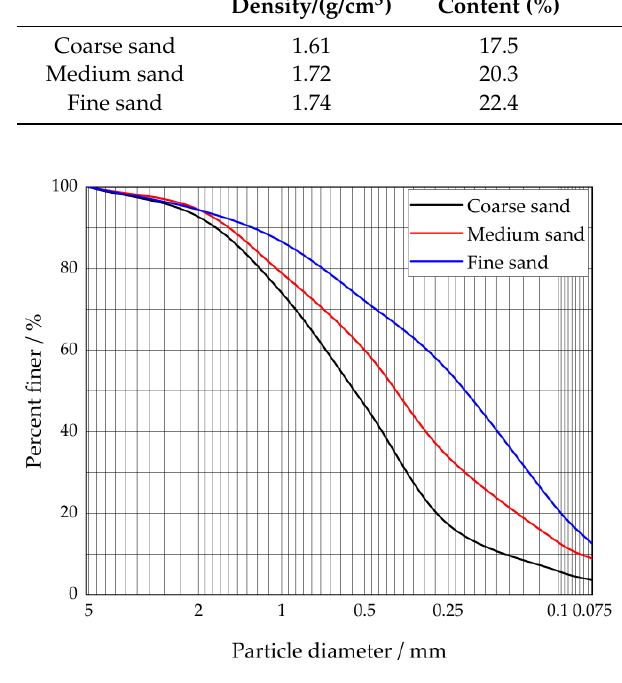
Figure 7. Test sand particle size gradation cumulative curve.